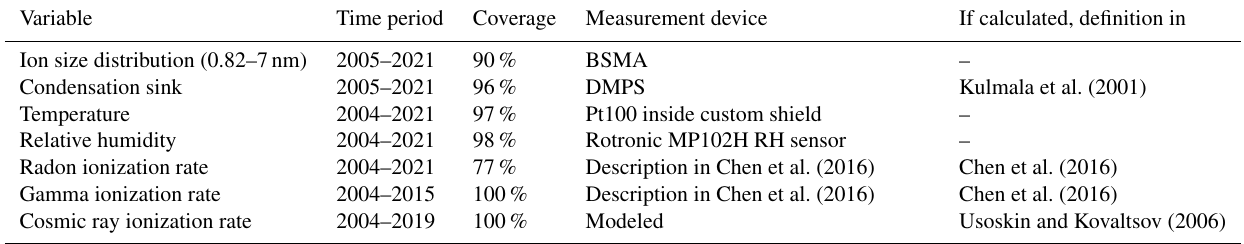
Table 1. The variables used to explain the variance in cluster and intermediate ion concentrations. Coverage is defined as the number of data points available in the time period